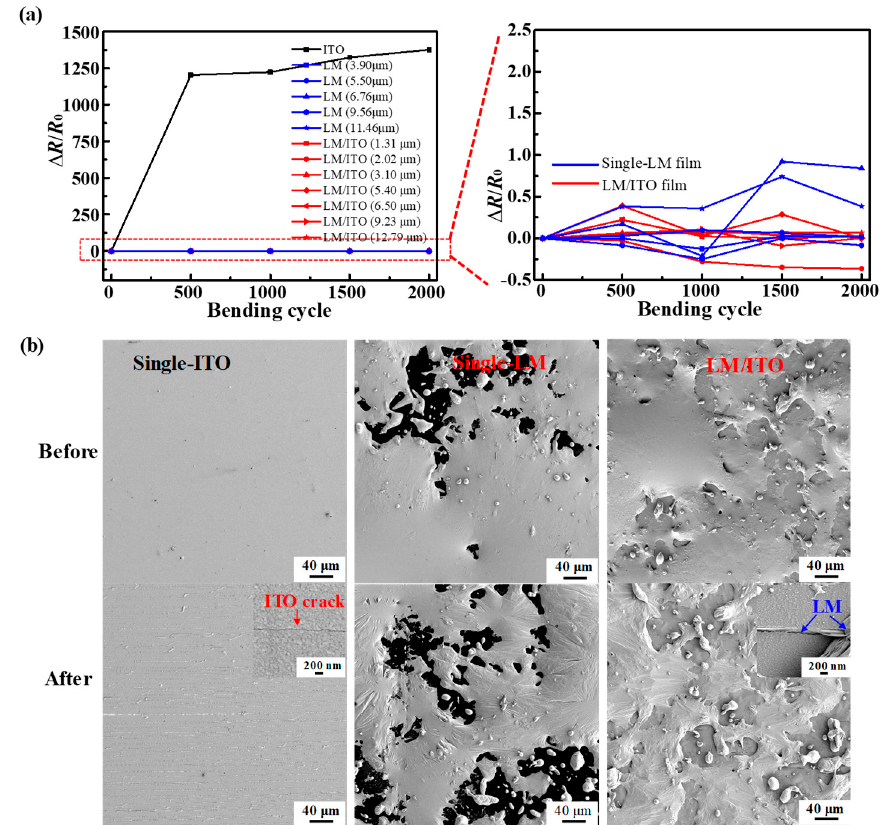
Figure 4. ( a ) Relative sheet resistance as a function of the bending cycles for the single-ITO, single-LM, and composite LM/ITO films. ( b ) SEM images of the single-ITO, single-LM, and composite LM/ITO film surfaces before and after the fatigue